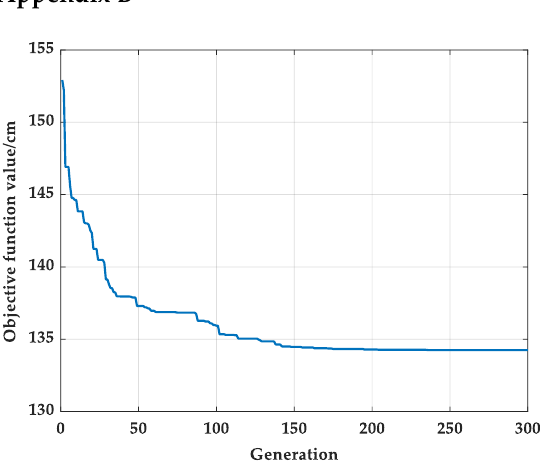
Figure A2. The evolution curve of ranging errors with signal interference.